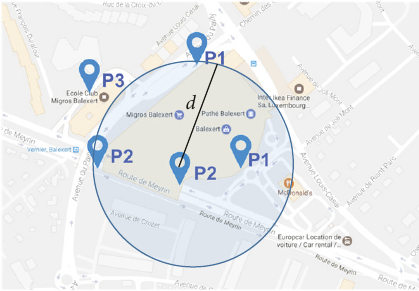
Figure 8: Smart parking for Balexert (two entrances for each of 𝑃1 and 𝑃2 ).